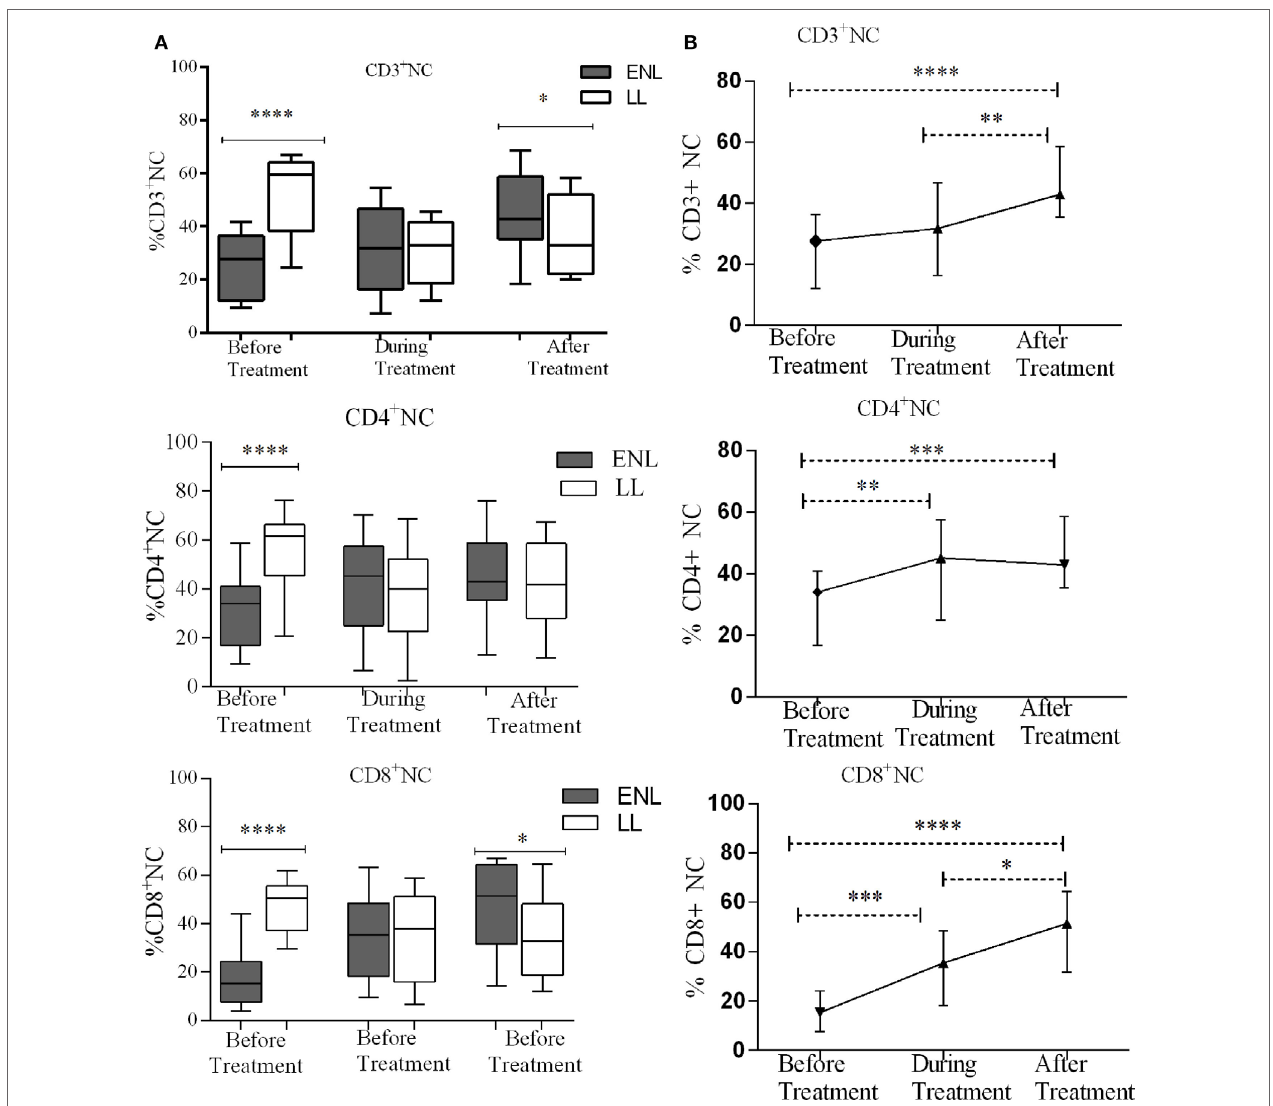
FigUre 7 | Median percentage of CD3 + , CD4 + , and CD8 + naïve T-cells: (a) in patients with erythema nodosum leprosum (ENL) and lepromatous leprosy (LL) controls before, during, and after treatment, (B) within ENL patients before, during, and after treatment. * P ≤ 0.05; ** P < 0.005; *** P < 0.001; **** P < 0.0001 . Box and whiskers (a) and error bars (B) show median ± interquartile